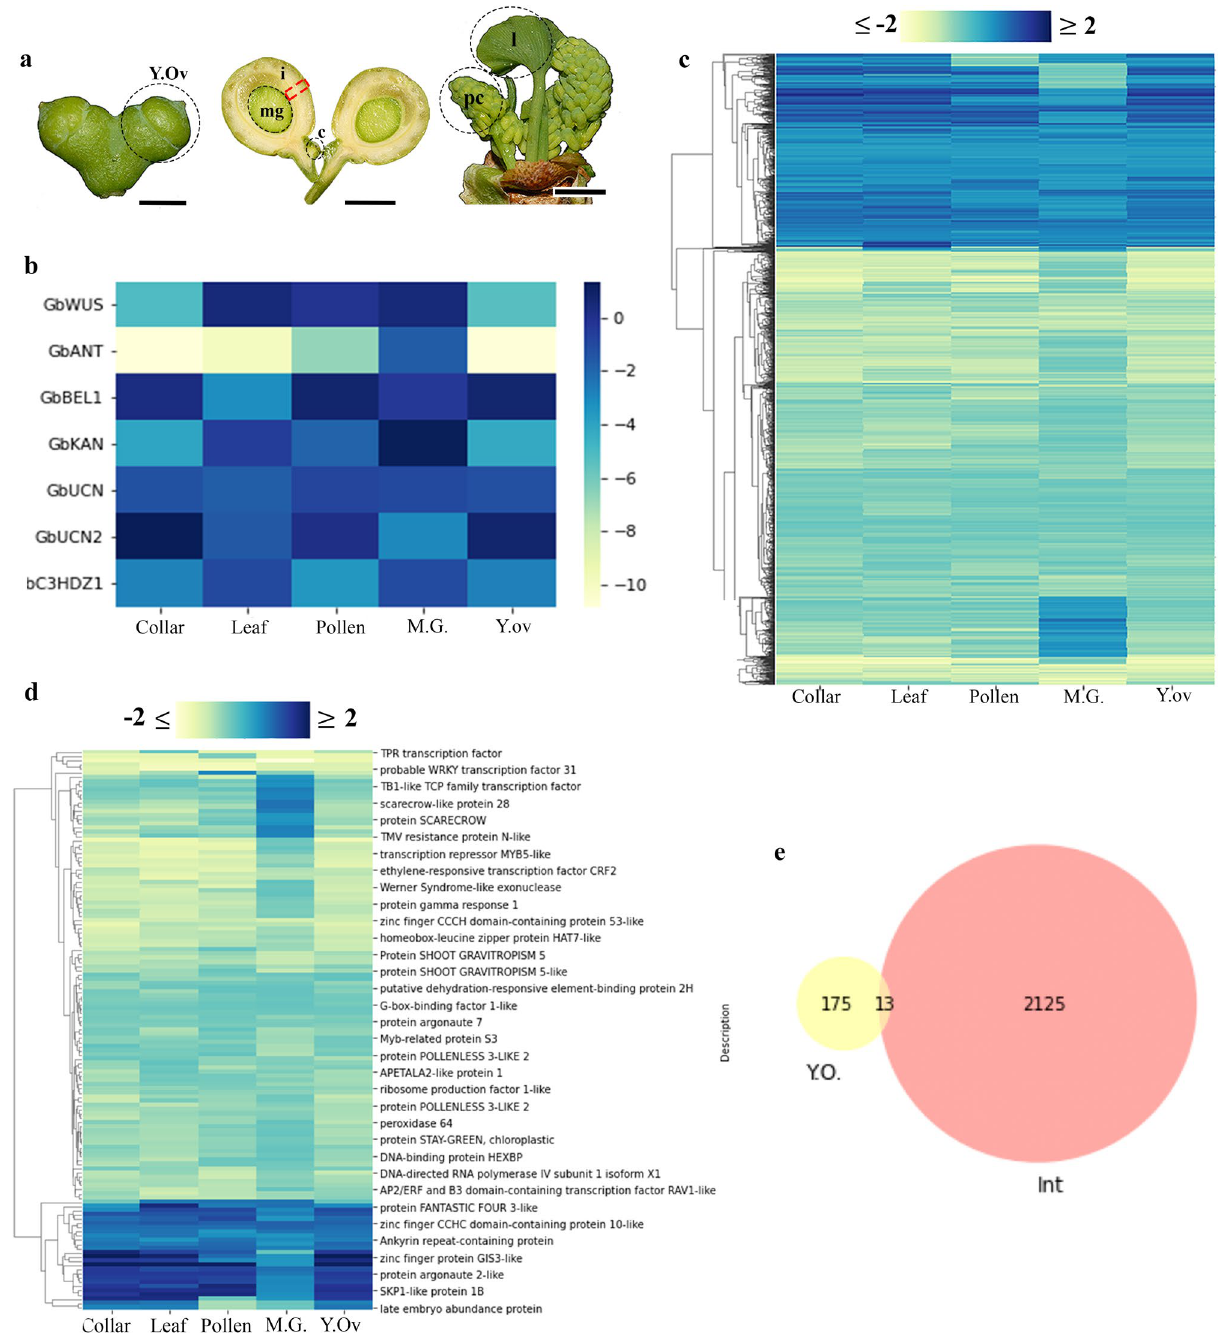
Figure 5. Transcriptome results focused on integument development. (a) Ginkgo samples that were sequenced separately to perform the differential expression analyses. Red square indicates the integument. (b) Heatmap of the genes from the integument developmental network differentially expressed in the integument. (c) Cluster map throughout all the tissues compared to the integument, 2137 Differentially Expressed (DE) genes with a fold expression change between − 2 and 2 and good transcriptional support (TPM ≥ 0.95). Each column of the cluster map indicated the twofold changes of each sample with respect to the integument. (d) 134 DE transcription factors differentially expressed in the integument compared to all the other samples. Two clusters were identified that largely consisted of up-regulated (blue clusters, n = 21) and down-regulated genes (yellow, n = 97). (e) Comparison of the DE genes between the young ovule sample and the integument. (f) Comparison of the DE genes between the megagametophyte and the integument. Blue , upregulated genes and yellow , downregulated genes ( b–d